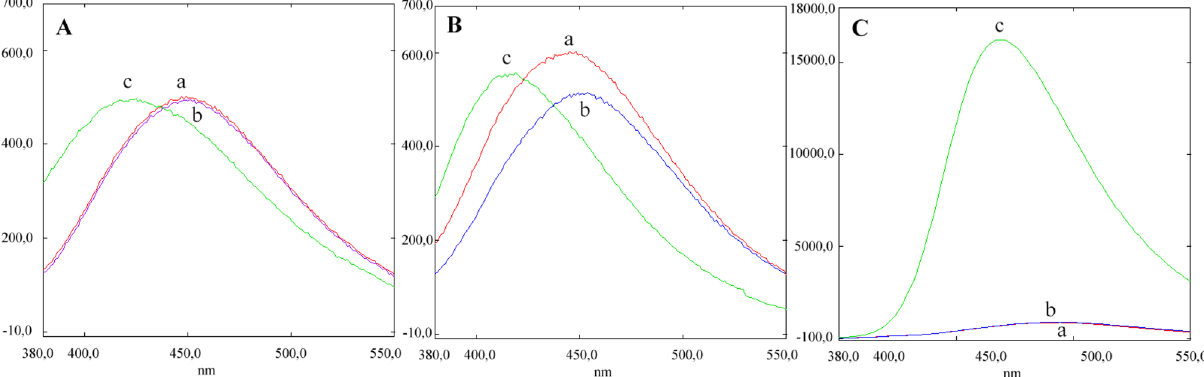
Figure 2. Effect of ( A ) pH 3, ( B ) pH 5 and ( C ) pH 9 on the fluorescence emission signals of (a) neochlorogenic acid, (b) chlorogenic acid and (c) caffeic